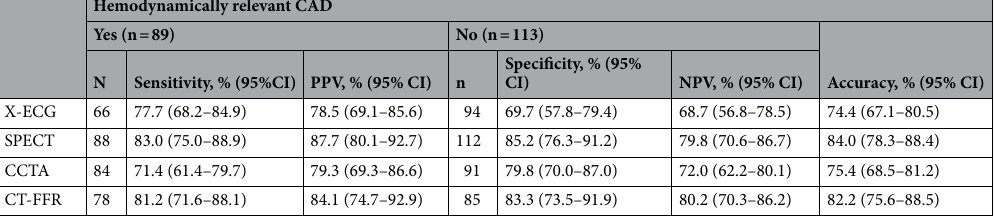
Table 2. Diagnostic performance of each diagnostic test compared to the reference standard outcome. CAD coronary artery disease, CCTA coronary computed tomography angiography, CI confidence interval, CT‑FFR computed tomography fractional flow reserve, NPV negative predictive value, PPV positive predictive value, X‑ECG exercise